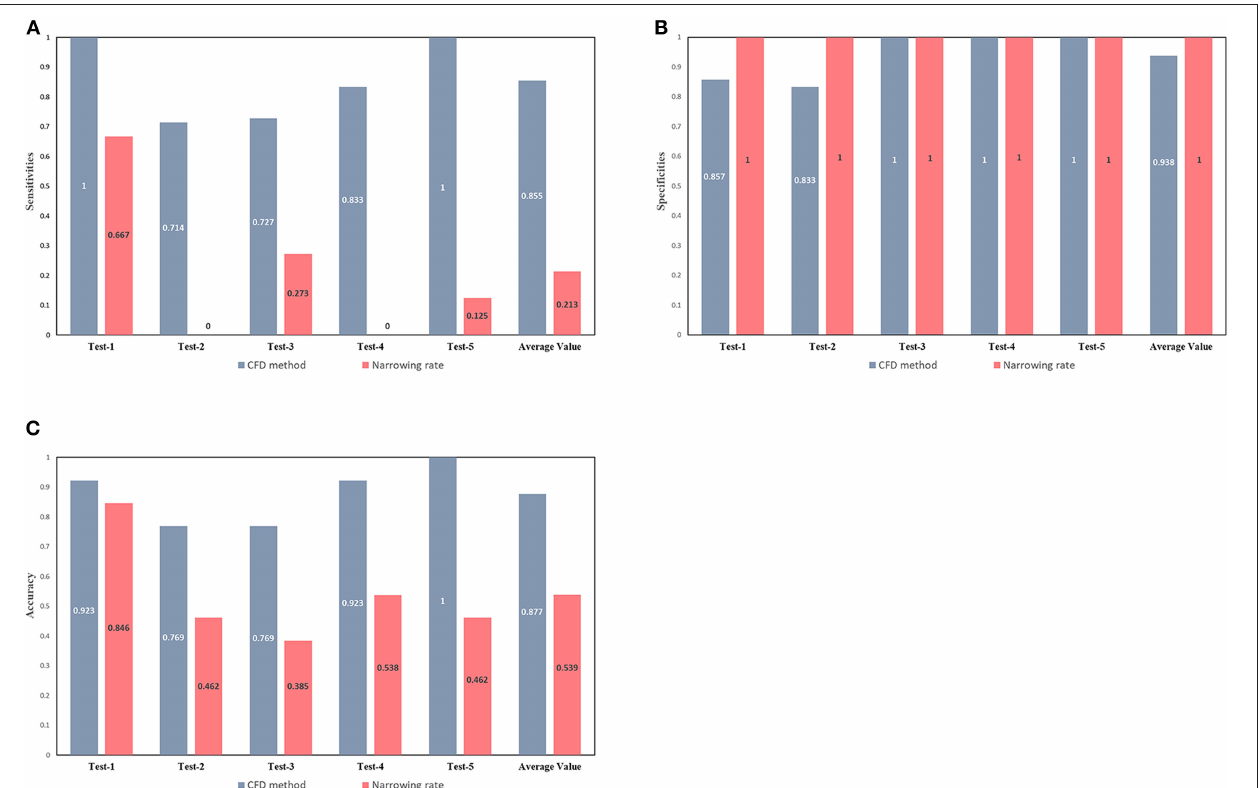
FIGURE 6 | Comparison between the diagnostic capacity of the CFD method and of the ESC guidelines criteria. Sensitivities (A) , specificities (B) , and accuracies (C) of CoA diagnoses conducted by the CFD (gray-blue bars) and the narrowing rate (pink bars) methods. The latter method was applied according to current guidelines. model (Menon et al., 2012b; Liu et al., 2016b); still, the